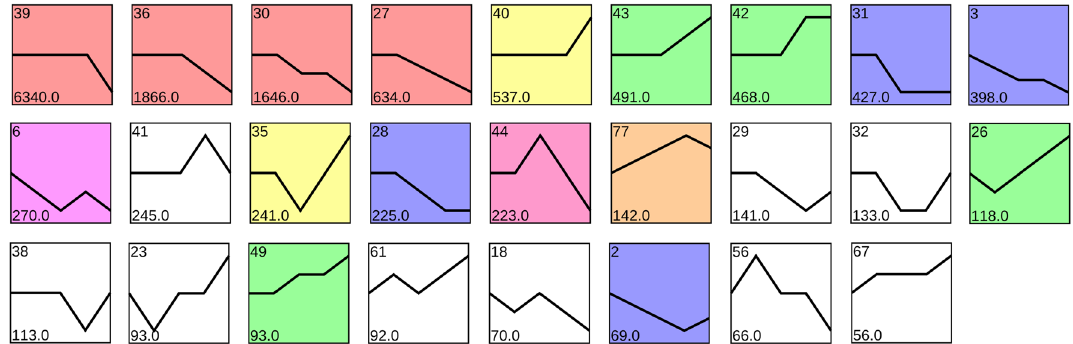
Figure 8. RNA-seq based transcriptome dynamics of 84 different expressed unigenes (68 of which are non- differentially expressed unigenes) related to ALA biosynthesis and TAG assembly through the 5 stages of sacha inchi seed development classified into 26 profiles. Note: blocks shaded with colours represent profiles with significant enrichment; blocks representing profiles with similar trends share the same color of shading; blocks without colour shading (i.e. white blocks) represent profiles without significant enrichment. The numbers in the bottom left corner of each block is the number of each